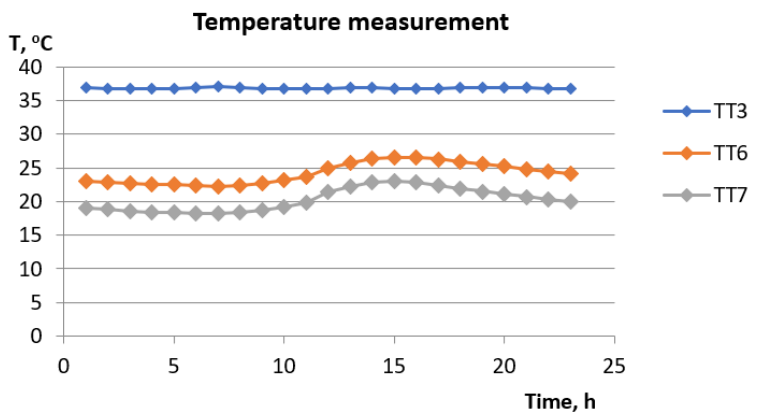
Figure 8. Temperature measurement—measurement points in accordance with the process diagram (Figure 4)—necessary for the production and desulphurization of agricultural biogas produced from a polydisperse substrate [own elaboration]: TT3—measurement inside the fermentor; TT6— measurement before desulphurizer; TT7—measurement after desulfurizer.